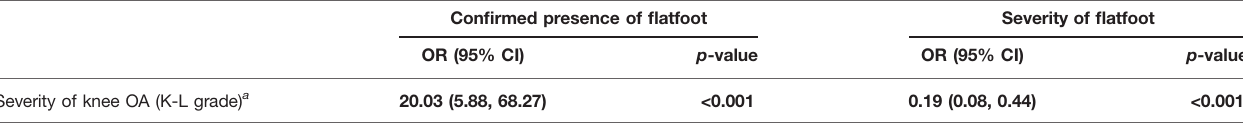
TABLE 4 | Regression analyses on the risk of K-L grade according to the presence of fl atfoot and the severity of fl